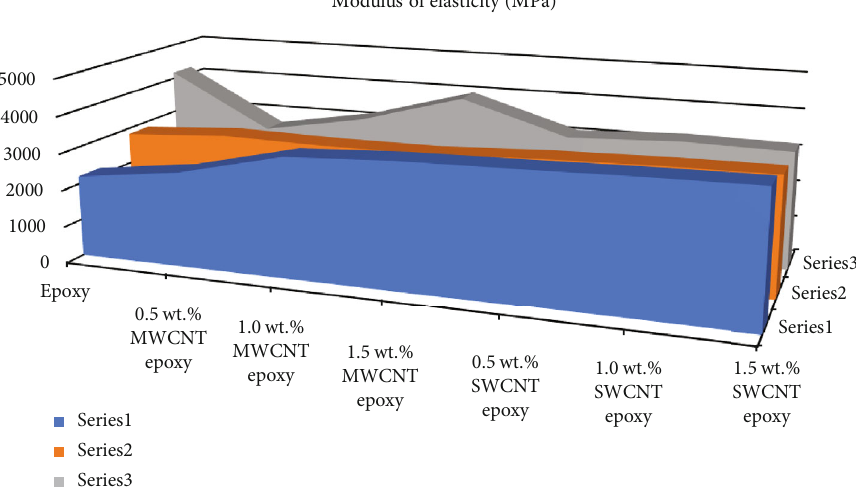
Figure 6: Average modulus of elasticity results for CNT-epoxy composite specimens obtained from the tension test.